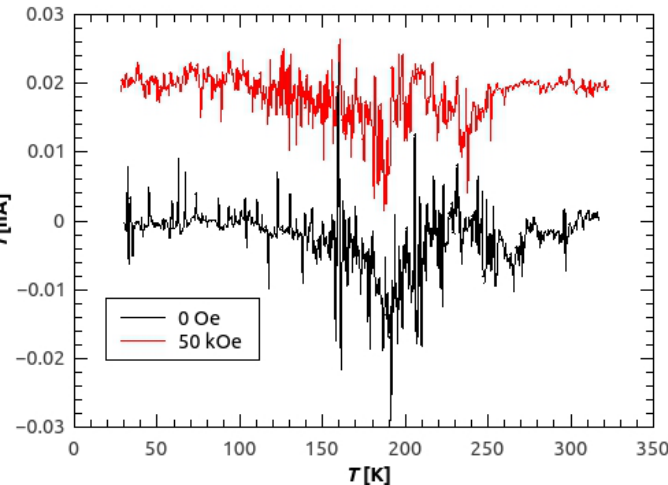
Figure A2. Pyroelectric current of [C(NH 2 ) 3 ]Cu(HCOO) 3 in 0 Oe (black line) and in 50 kOe (red line). For the measurements in 50 kOe, the constant of 0.02 nA was added in order to separate the curves by translation.